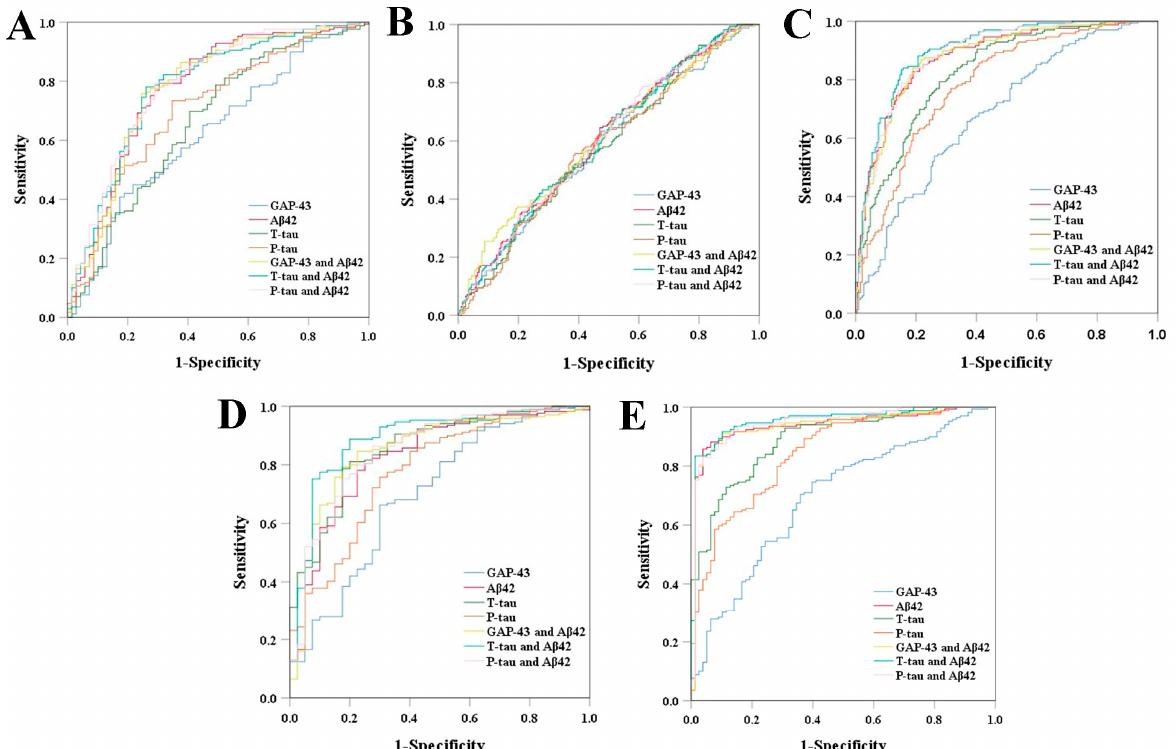
Figure 3. ROCs for the diagnostic accuracy of CSF biomarkers. CN ε 4– versus CN ε 4+ ( A ), CN ε 4– versus MCI ε 4– ( B ), CN ε 4– versus MCI ε 4+ ( C ), CN ε 4– versus AD ε 4– ( D ) and CN ε 4– versus AD ε 4+ ( E ). GAP-43: growth-associated protein 43; A β : amyloid- β ; T-tau: total tau; P-tau: phosphorylated tau.